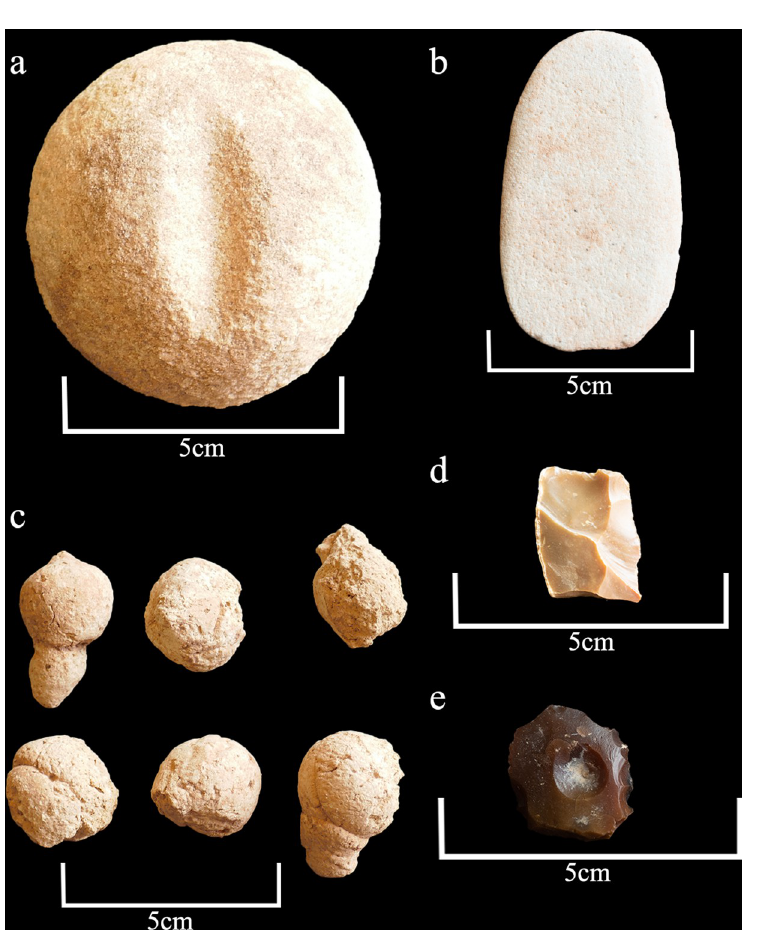
Fig 19. A selection of small finds from mustatil IDIHA-F-0011081. a: transverse grooved hammer stone (sandstone). b: polished grinder (sandstone). c: animal (hyena) coprolites. d: retouched flake. e: retouched side scraper.